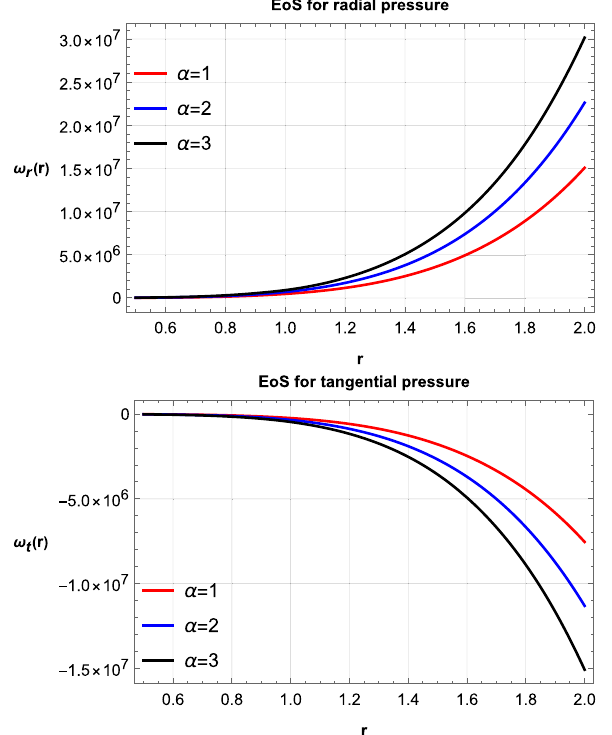
Fig. 10 The EoS parameter ω for two-sphere (case-1) with r 0 = 1 and A = 0 .